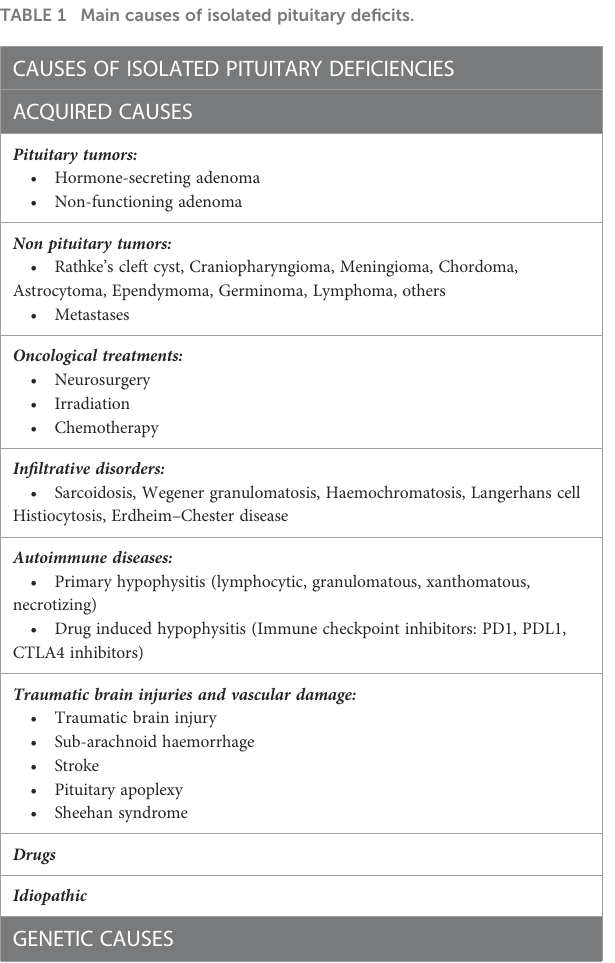
TABLE 1 Main causes of isolated pituitary de fi